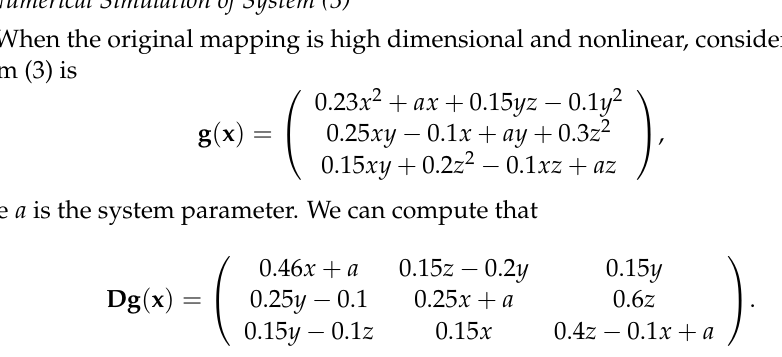
Figure 10. Exponential Lyapunov spectrum of system (3).